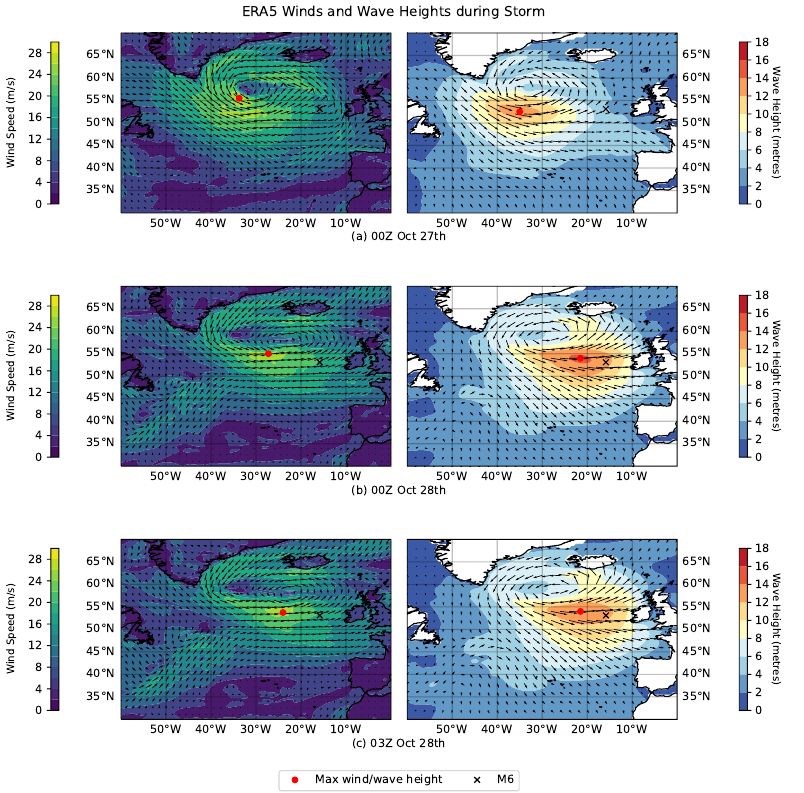
Figure 7. ERA5 mean winds and combined (swell and wind) significant wave heights and direction in the 27 h leading up to rogue wave measurement at 03Z on 28 October. The location of maximum wind speeds/wave heights is indicated, along with the M6